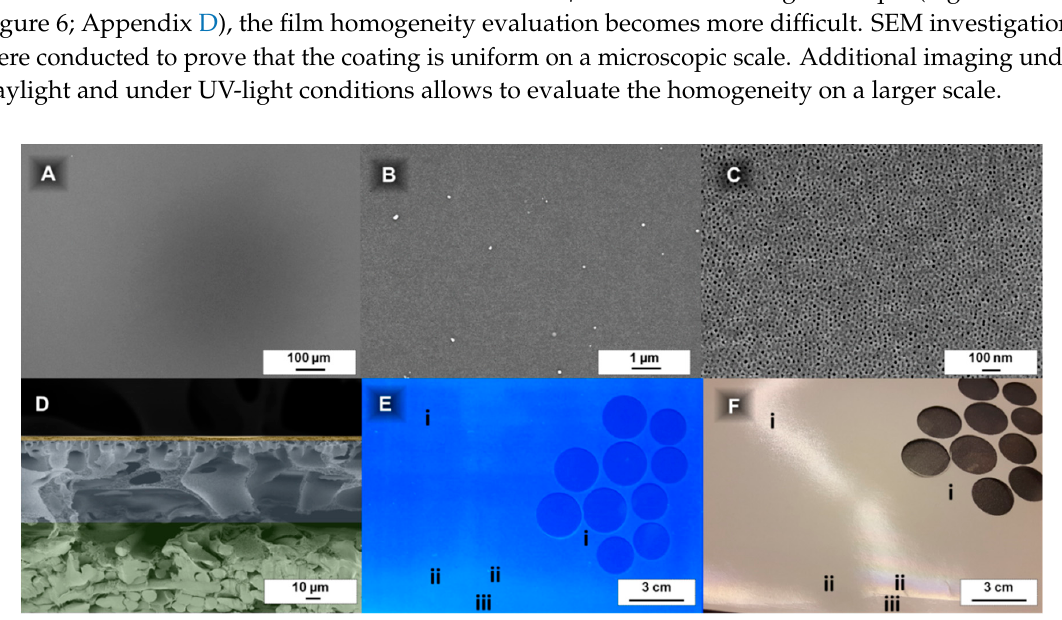
Figure 2. Film homogeneity quantification of a roller coated PS 83 - b -P4VP 1788k _DOX 1001 membrane: The scanning electron microscope (SEM) images show a homogenous coating in the range of 100 nm up to 1000 µm ( A – C ) without hints of defects; The cross-sectional view ( D ) indicates a homogenous layer thickness of PS 83 - b -P4VP 1788k (top; yellow) on top of the polyacrylonitrile (PAN) support membrane (PAN, middle; blue and non-woven, bottom; green) without penetration of the same; Under UV light 253 nm the PS- b -P4VP layer appears homogenous on a PAN membrane over a large scale and parts of the inhomogeneous coating could be easily made visible by this method ( E ); By observation of the reflections against a light source coloured areas of the PS- b -P4VP film indicate the beginning of the shrinking of the film thickness (ii) at the edges and that were excluded from further use (usually ~2 cm) ( F ). Locations designated by Roman numerals are explained in the text.